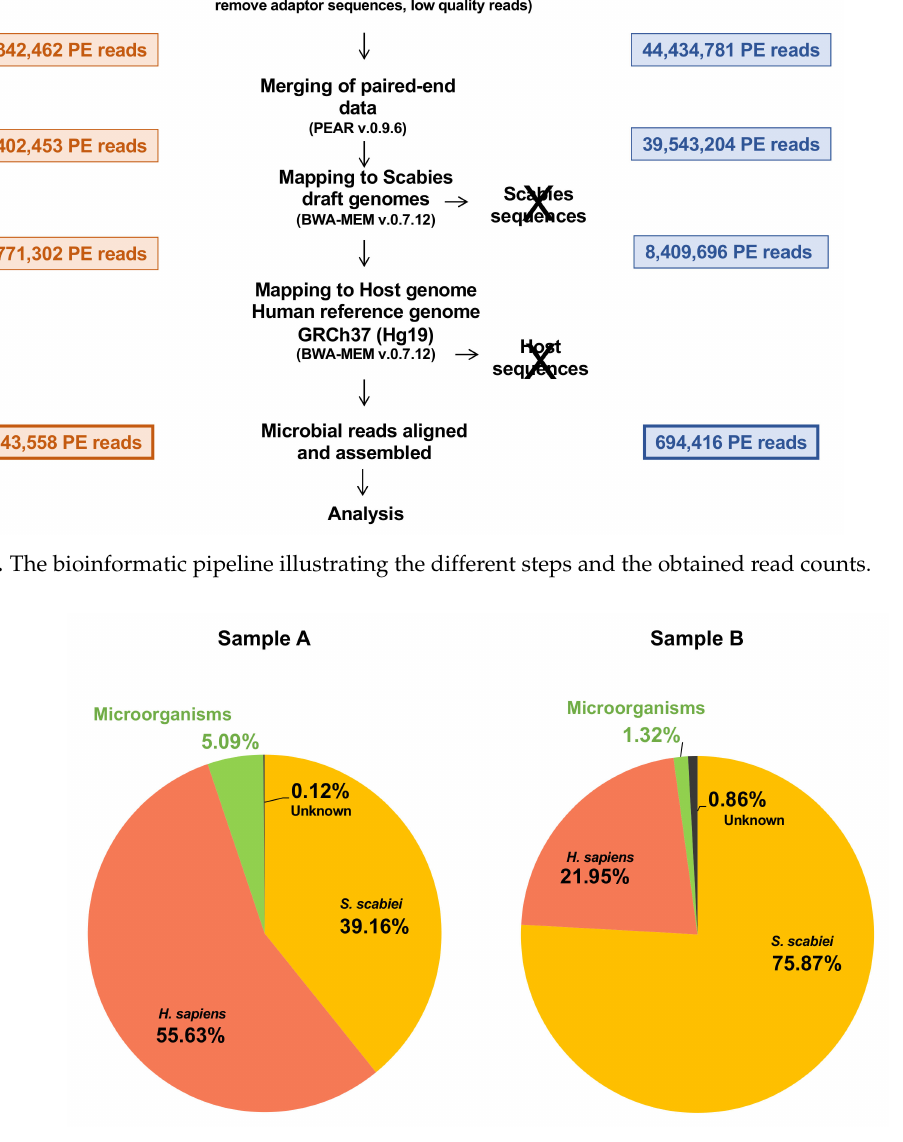
Figure 2. The repartition of the reads sequenced from each patient sample (Patient A and B). Two ~45 to 50 million paired-end read Illumina libraries were generated, of which ~2 million (5.09%) for Patient A and 0.7 million (1.32%) for Patient B were attributed to microbial reads. The other reads were corresponding to human genome ( H. sapiens ) or mite genome ( S. scabiei ) sequences. A small proportion could not be attributed